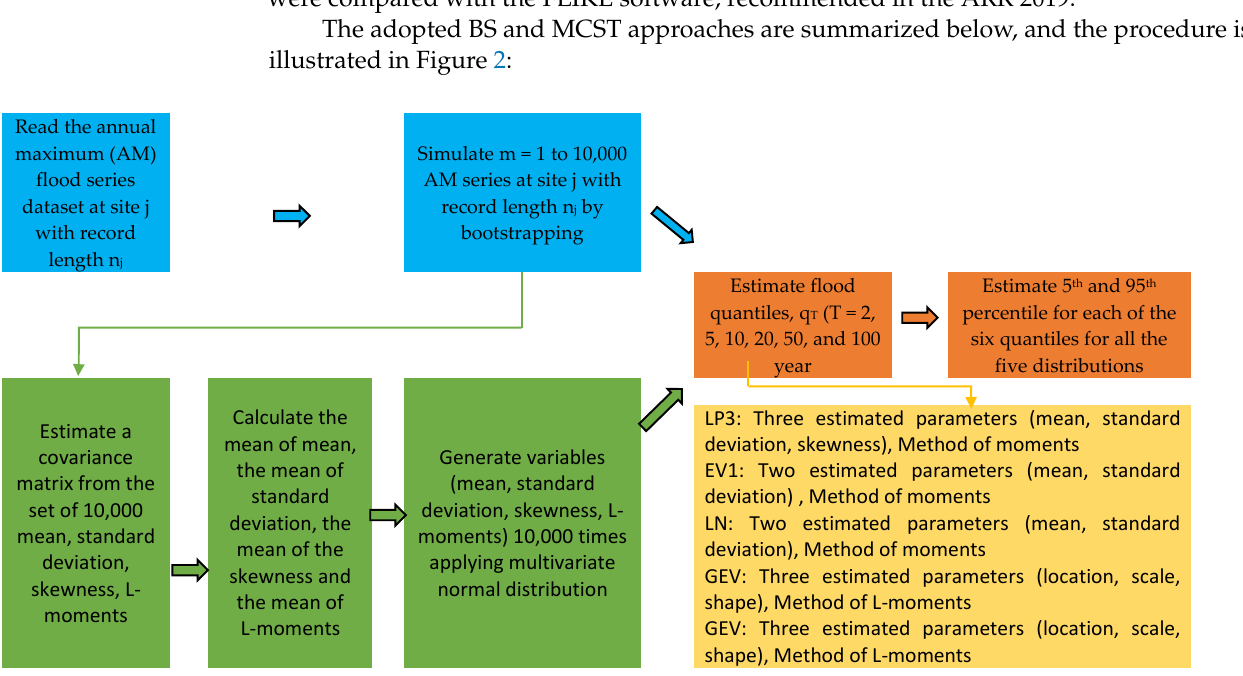
Figure 2. Computation flowchart of estimating flood quantiles using bootstrapping and Monte Carlo methods.